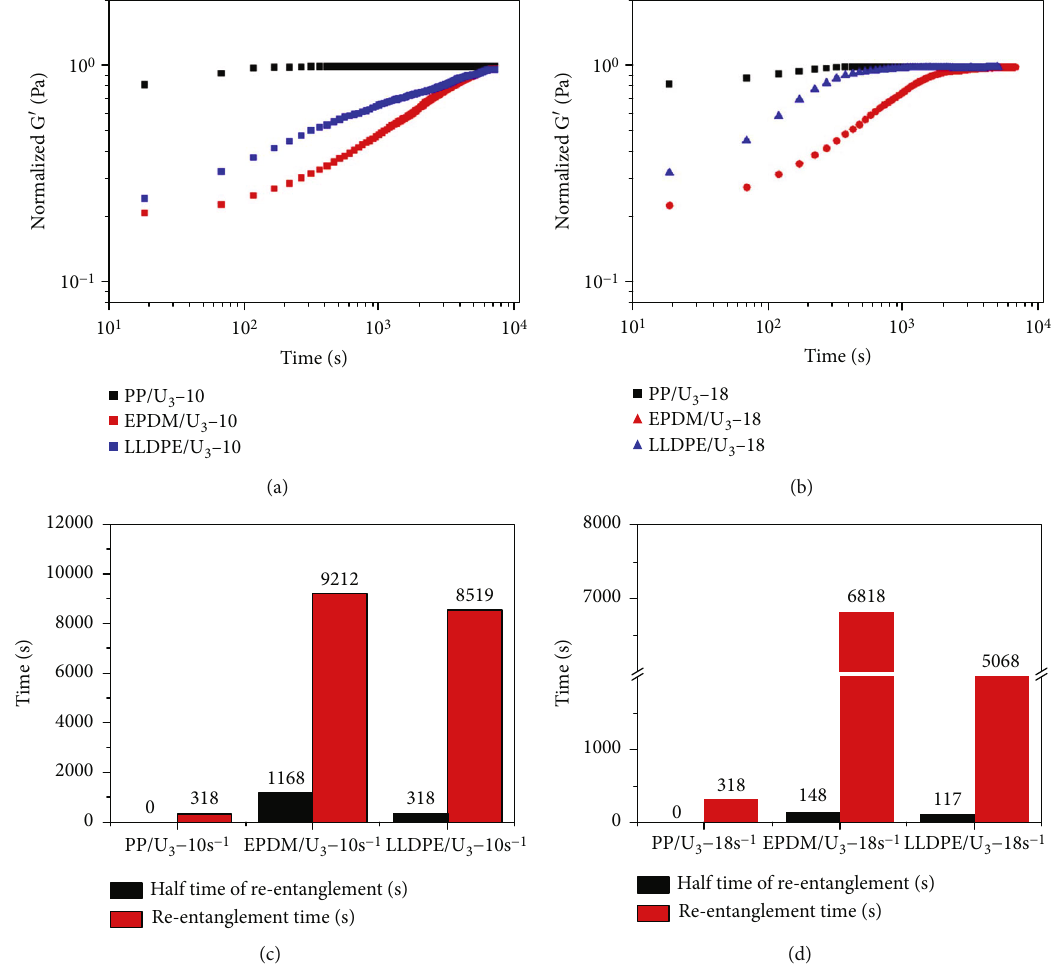
Figure 7: (a, b) Buildup of normalized storage modulus of selected samples with time at 190 ° C. Half time of reentanglement and reentanglement time after shear modi fi cation: (c) terminal shear rate: 10 s -1 and (d) terminal shear rate: 18s -1 .